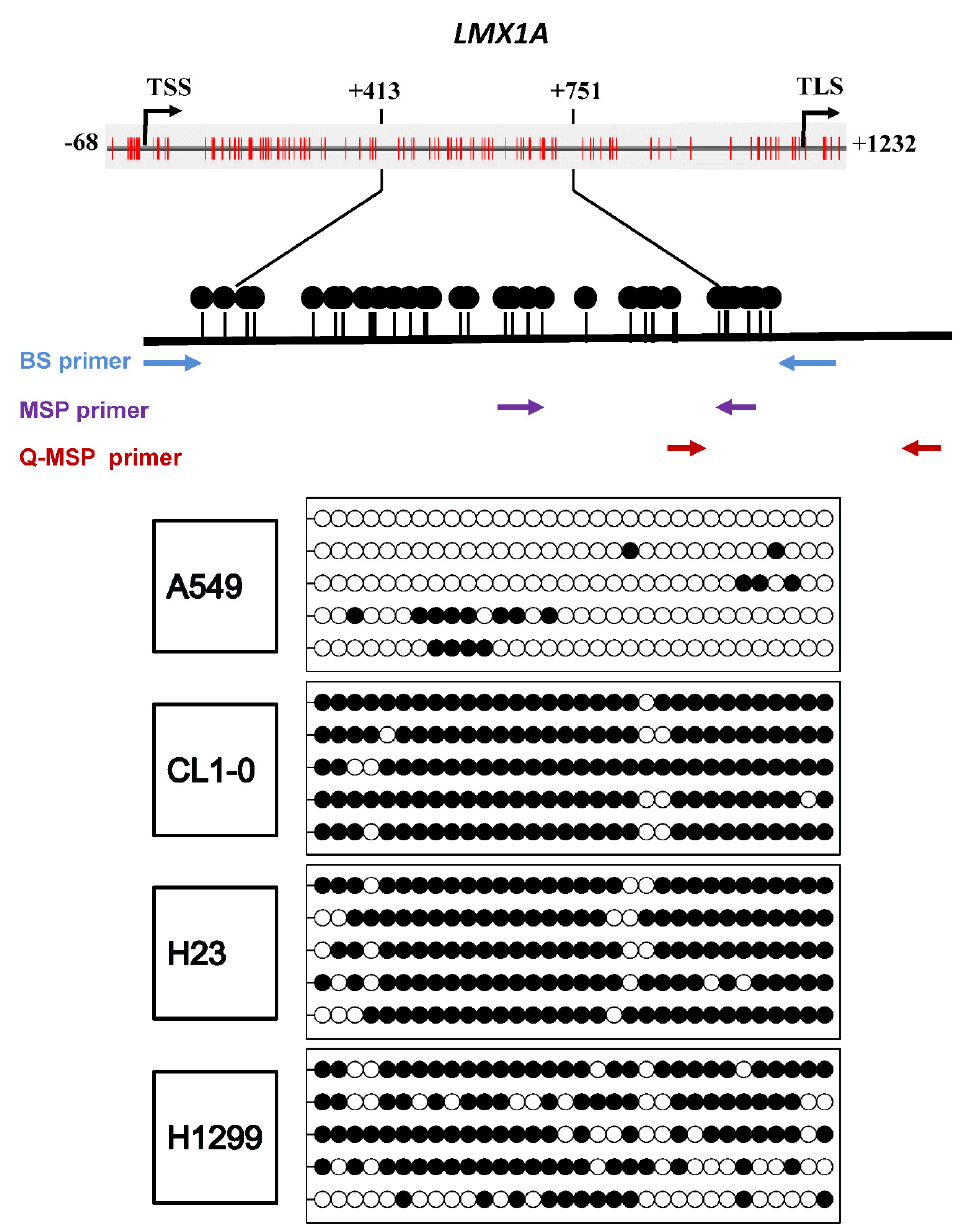
Figure 2. Bisulfite genomic sequencing analysis of the CpG sites located at the promoter region of LMX1A . The LMX1A methylation status in four NSCLC cell lines was analyzed by bisulfite genomic sequencing. Each clone is represented by a row, and 32 CpG sites are represented as circles. Black circles and white circles represent methylated and unmethylated CpG sites, respectively. Arrows indicate the locations of the BS primers, MSP primers, and Q-MSP. TSS: Transcriptional start site; TLS: Translational start site; BS: Bisulfate sequencing; MSP: Methylation-specific PCR; Q-MSP: quantitative methylation-specific PCR.